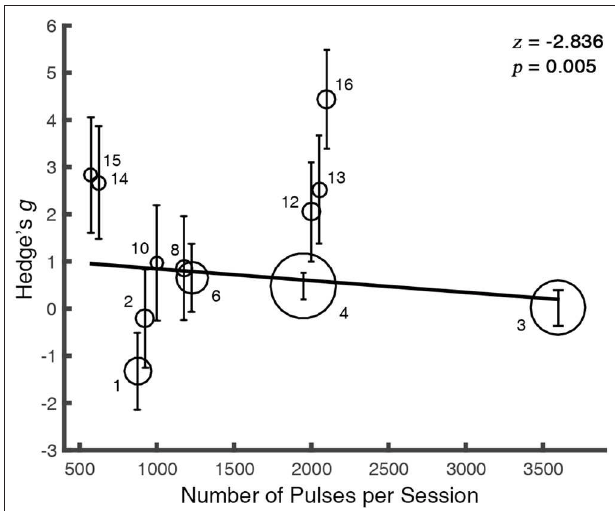
FIGURE 4 | The therapeutic outcome is modulated by the number of pulses per session. For clarity, the overlapped values of regressor were randomly jittered. The solid line is the fixed-effect regressive function for the regressor. The size of each bubble represents the study’s relative weight which was calculated as the inverse of the variance. Error bars indicate the 95% CIs. The markers abut to the bubbles correspond to the index of studies in the Appendix